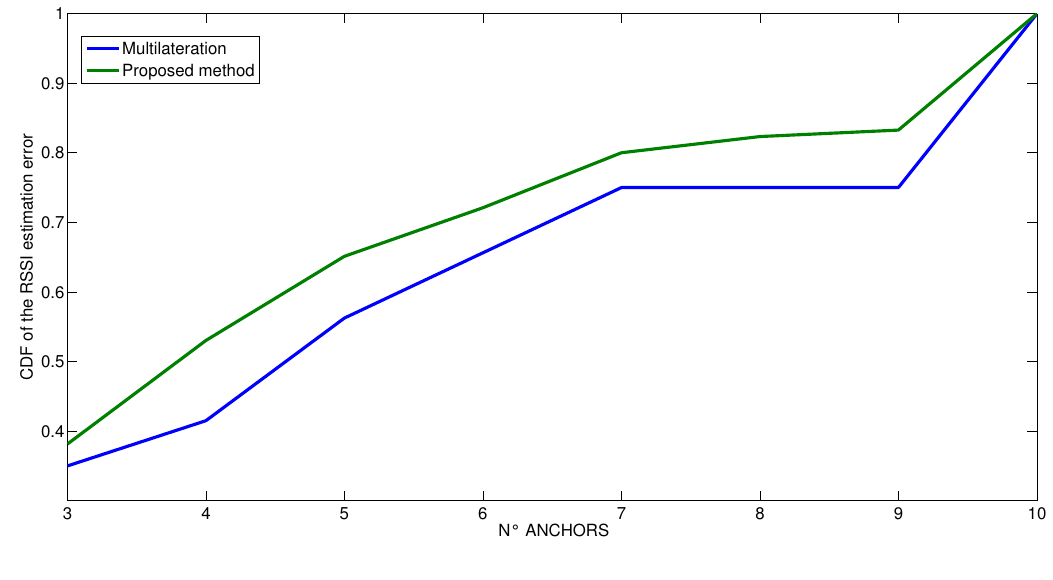
Figure 12. Cumulative Distribution Function of the RSSI estimation error at varying number of anchors for the conference room scenario.